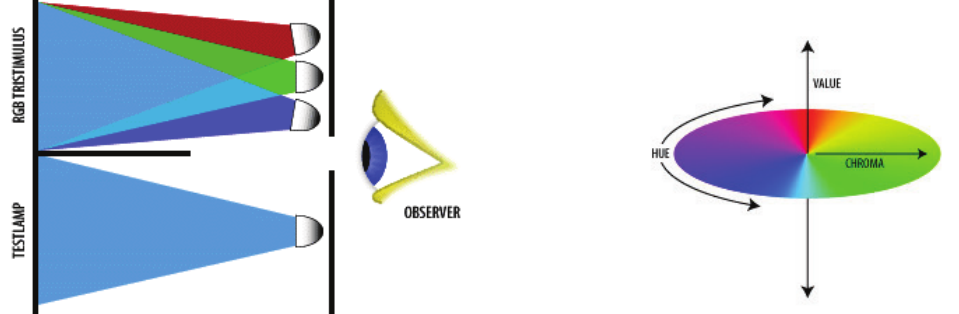
Figure 2. CIE and Munsell color models. Left : CIE color model. Right : Munsell color